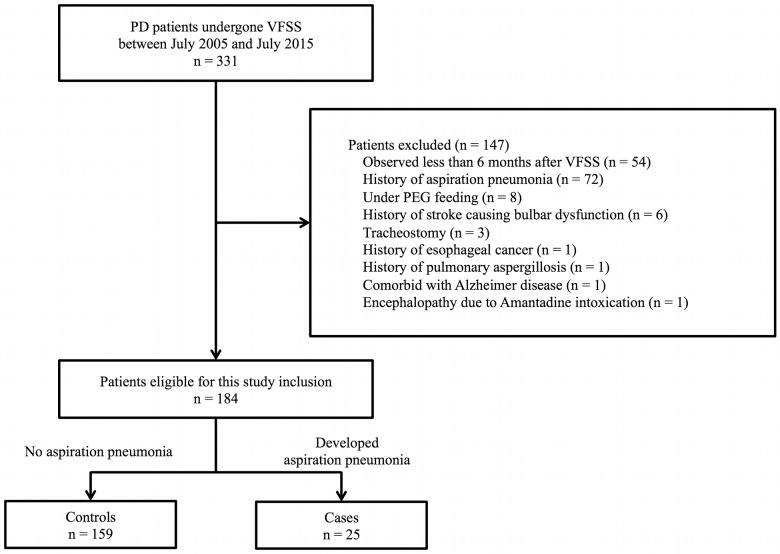
Flow diagram of participants included in the study.